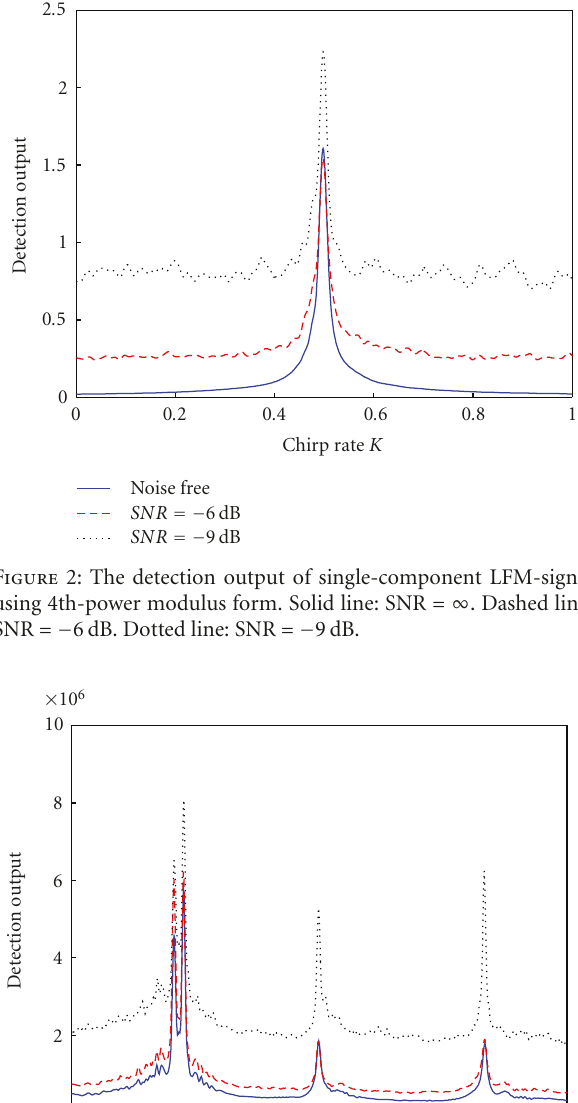
Figure 5: The detection output of multicomponent LFM-signal with SNR = − 6dB using the 5th-power modulus